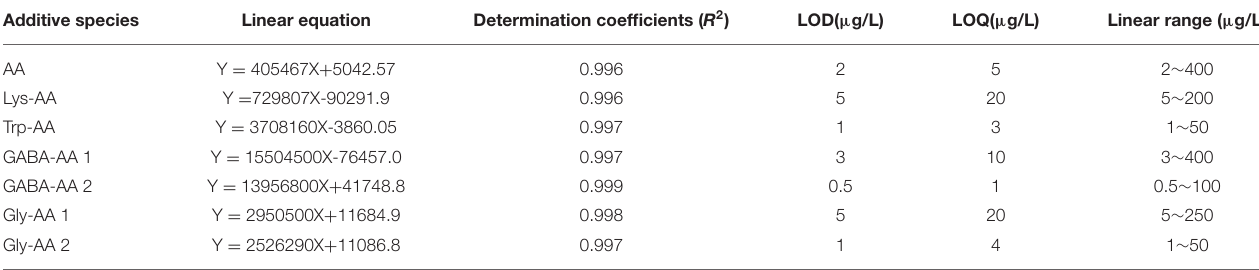
LOD, Limit of Detection. LOQ, Limit of Quantitation.